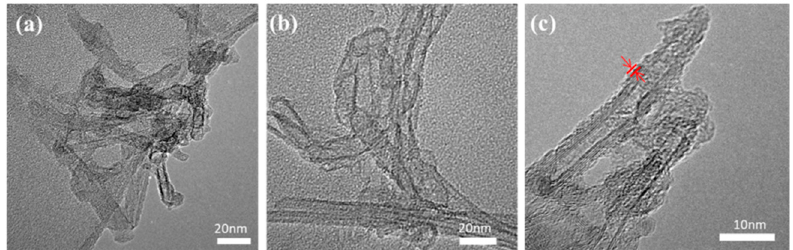
Figure 2. TEM images of ( a ) original carbon nanotubes (CNTs), ( b ) oxidized CNTs and ( c ) organically modified CNTs.